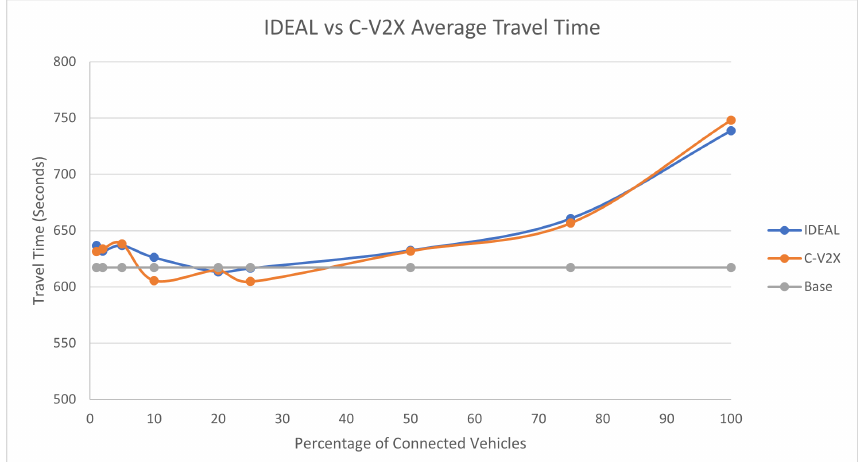
Figure 8. Average network-wide Travel Time of Energy-Efficient dynamic routing application using IDEAL and C-V2X communication on LA road network with traffic demand of scale factor 0.75.